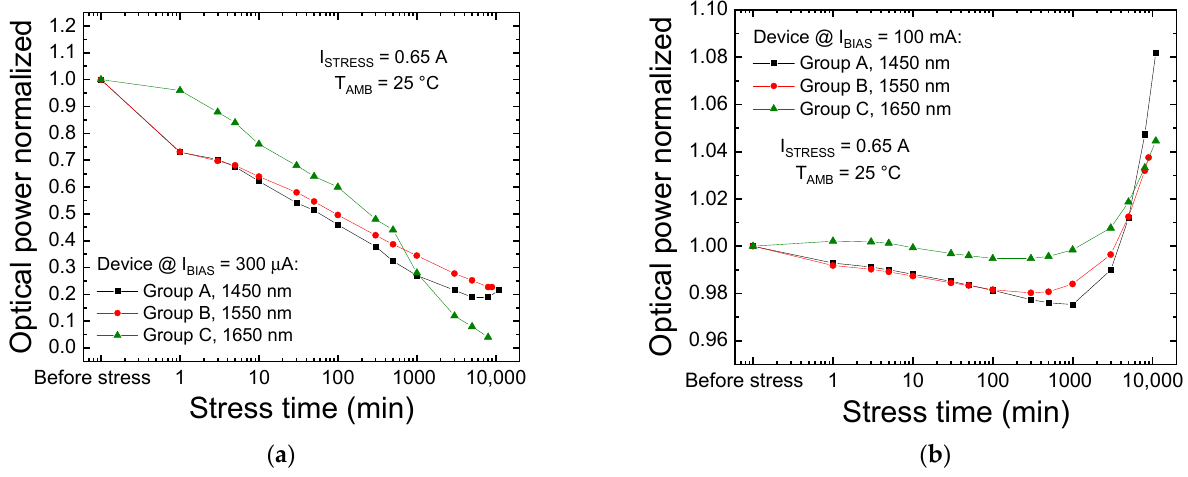
Figure 7. Trend of the optical power measured at T AMB = 25 °C after each stress cycle for one representative LED of each group. ( a ) Optical power (OP) trend at 100 mA (nominal current) and ( b ) at 300 μ A. Data are related to the constant-current stresses performed at T STRESS = 45 °C.